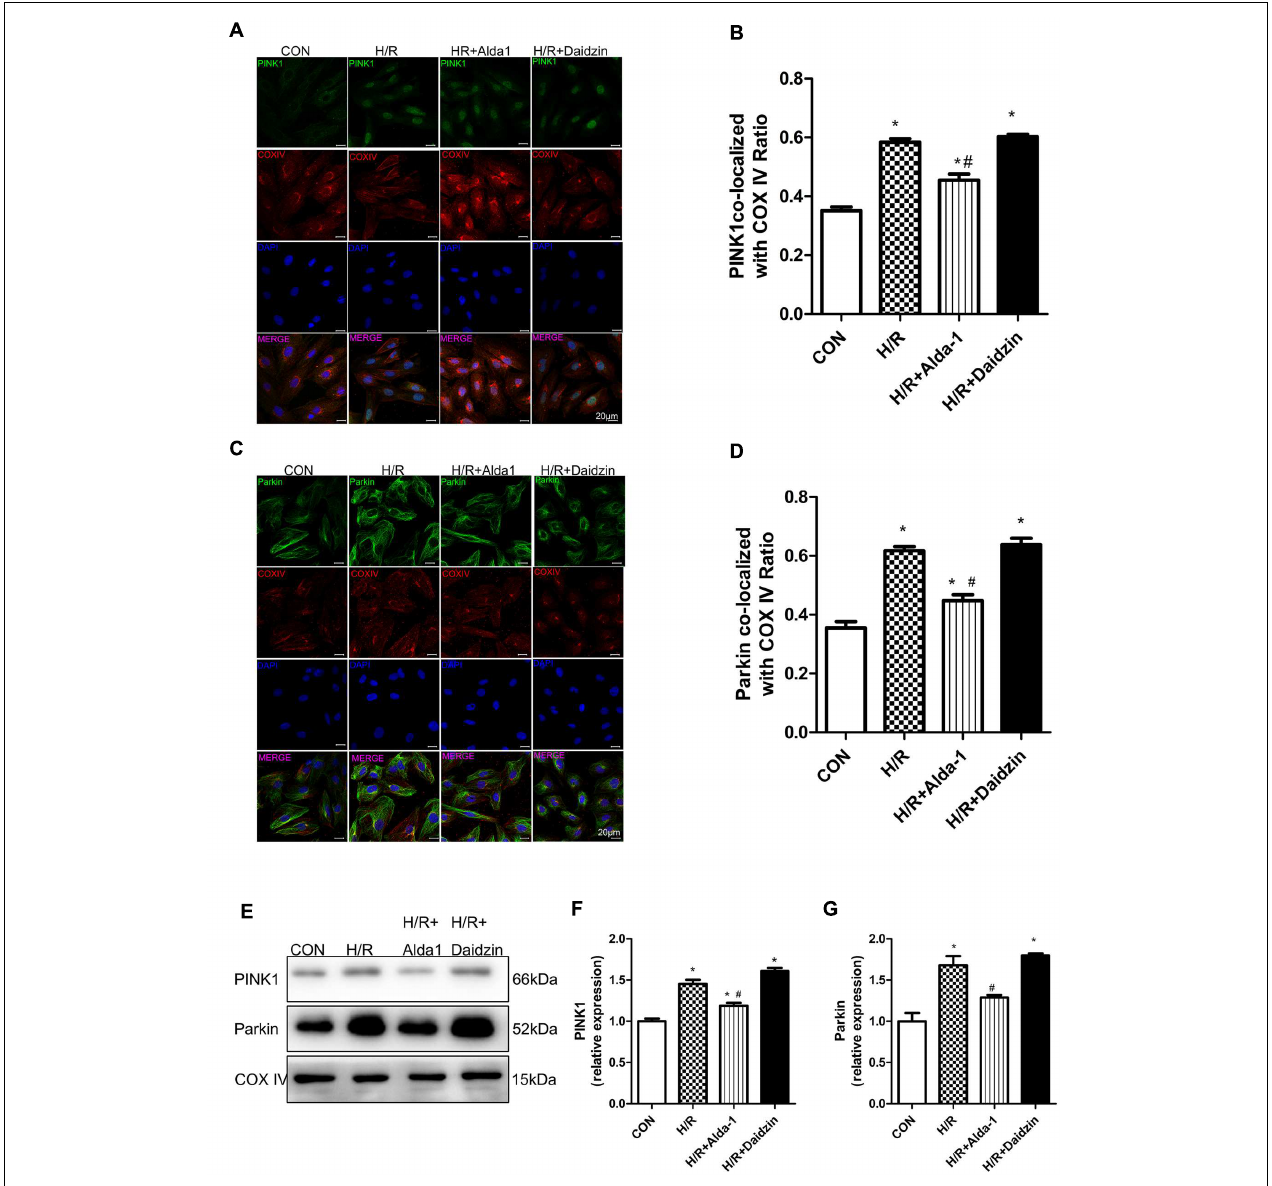
FIGURE 5 | Mitophagy in H/R-treated H9C2 cells. (A) Representative immunostaining of co-localization of PINK1 and COX IV. (B) Co-localization ratio of PINK1 and COX IV. ( P < 0.0001, One-way ANOVA). (C) Representative immunostaining of co-localization of Parkin and COX IV. (D) Co-localization ratio of PINK1 and COX IV ( P < 0.0001, One-way ANOVA). (E) Representative gel blots of expression of PINK1, Parkin and COX IV (mitochondrial loading control). Quantification analysis of (F) PINK1 expression, (G) Parkin expression ( P < 0.0001, P = 0.003, One-way ANOVA). Representative images are shown (magnification, 630 × ). Scale bar: 20 µ m. Representative immunostaining of 3 independent experiments. Data are mean ± SD from 3 independent experiments. ∗ P < 0.05 vs. CON; # P < 0.05 vs.